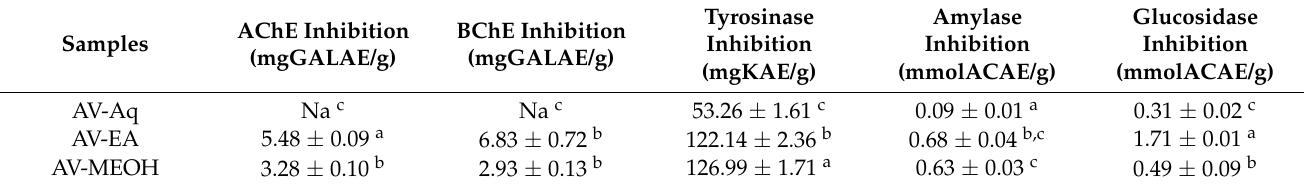
Table 6. Results of the tyrosinase, cholinesterase, amylase, and glucosidase